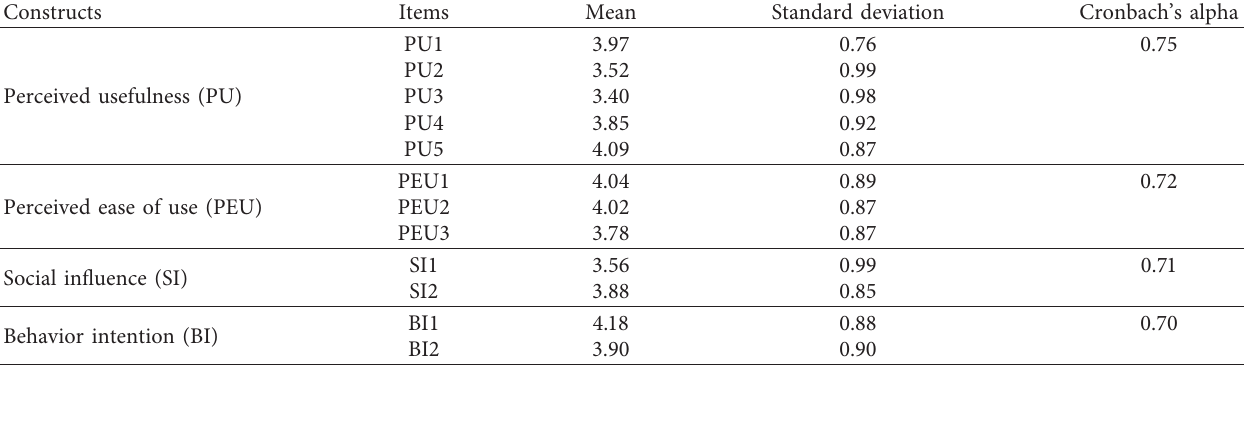
Table 3: The results of measurements, means, standard deviations, and reliability.